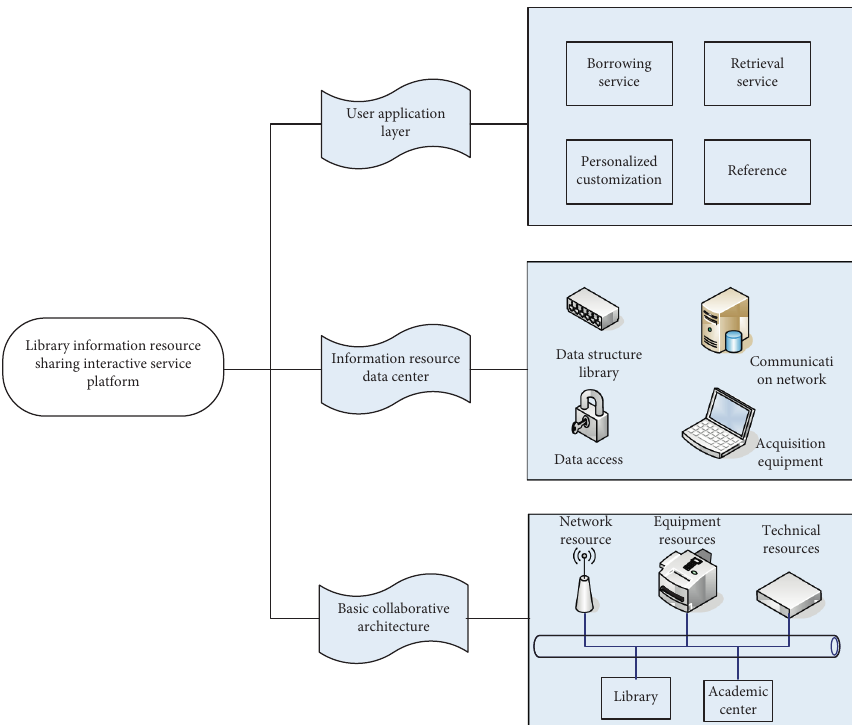
Figure 3: Library information resource sharing interactive service platform.